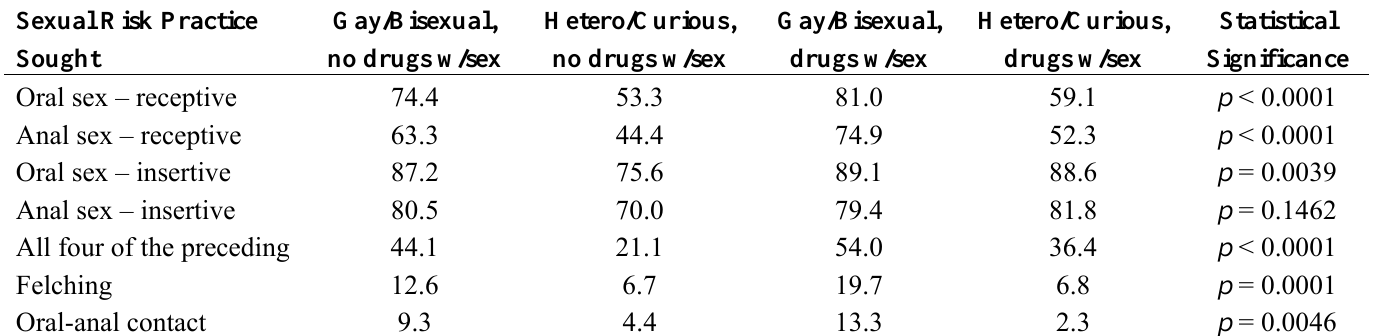
Table 1. Differences in Sexual Risk Practices Sought, by Sexual Orientation and Drug Use